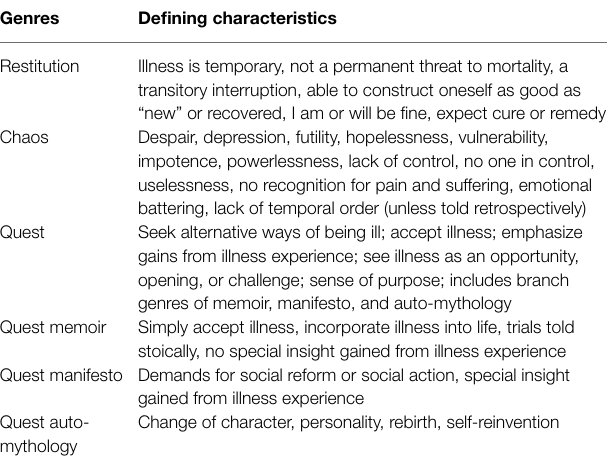
TABLE 1 | Frank’s narrative